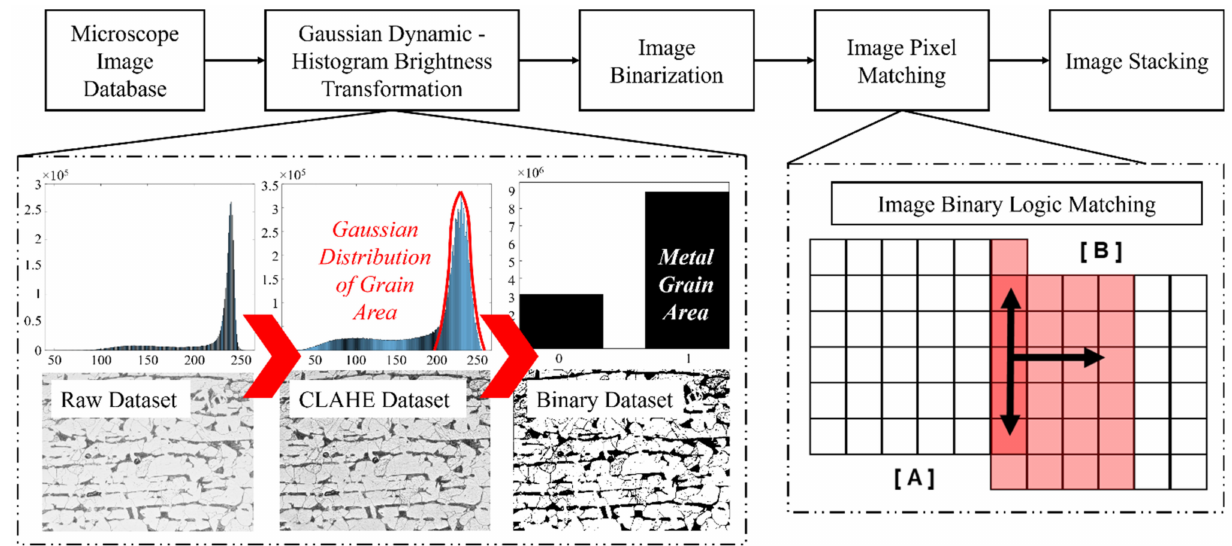
Figure 4. Flow chart of microscope image-stitching algorithm: image binarization using Gaus- sian dynamic histogram brightness transformation (GD-HBT), image binary logic matching, and data